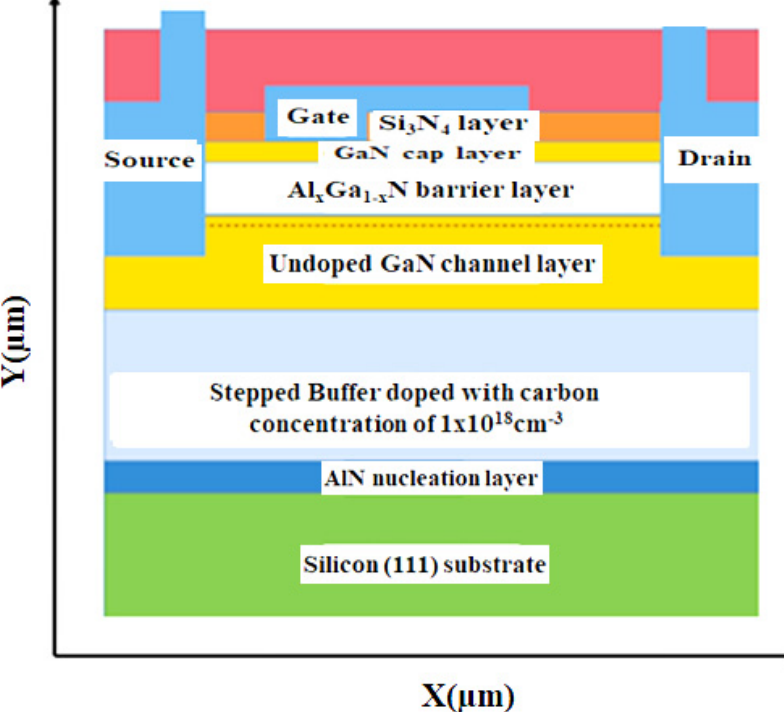
Figure 1. The conventional device structure of GaN/AlGaN/GaN HEMT. The charges for GaN/AlGaN/GaN device at each interface are defined as shown in Figure 2 for the physical simulator [39]. The effect of strain relaxation on the piezoelectric charges was not accounted for simulation [40]. This strain relaxation would not